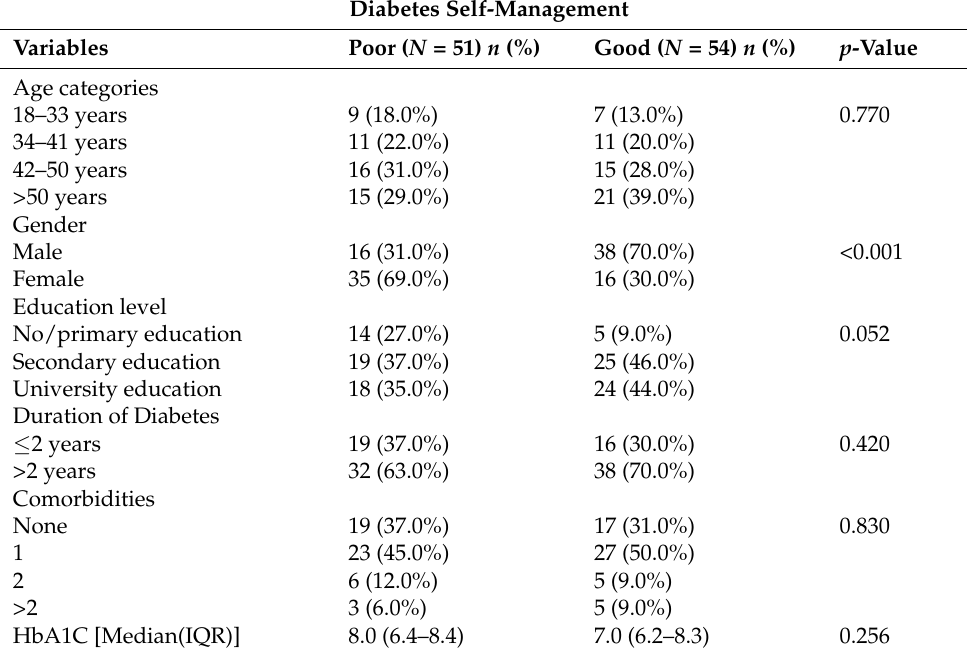
Table 2. Diabetes self-management status according to baseline characteristics of